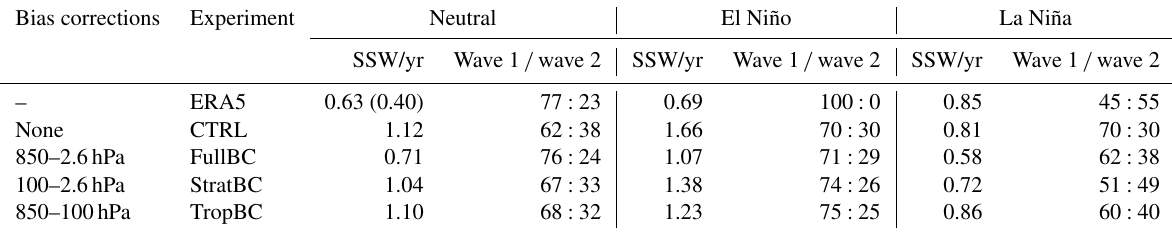
Table 1. Experiment names and details for bias correction and ENSO experiments. Number of SSWs per year calculated from 100 years in the model experiments and 41 years of ERA5 data. For ERA5, the SSW frequency in the third column is shown for all years and only for years with a neutral ENSO in brackets. The wave 1 : wave 2 ratio is based on the heat flux at 100hPa, 45–75 ◦ N. Bias corrections